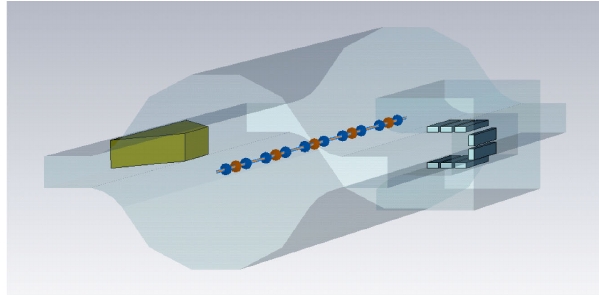
FIG. 15. CST 3D model of the FCC-ee chamber and a SR absorber with pumping